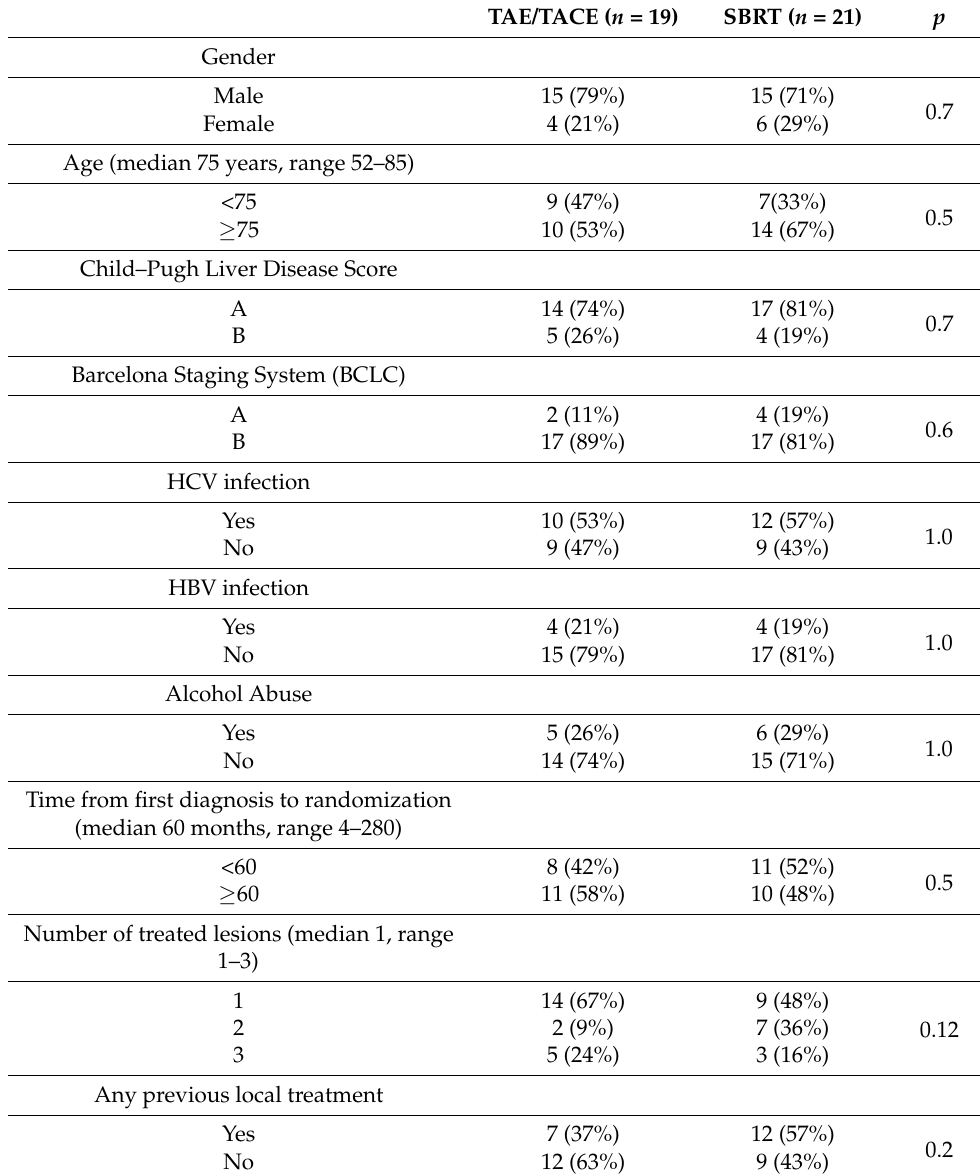
Table 1. Patient- and treatment-related